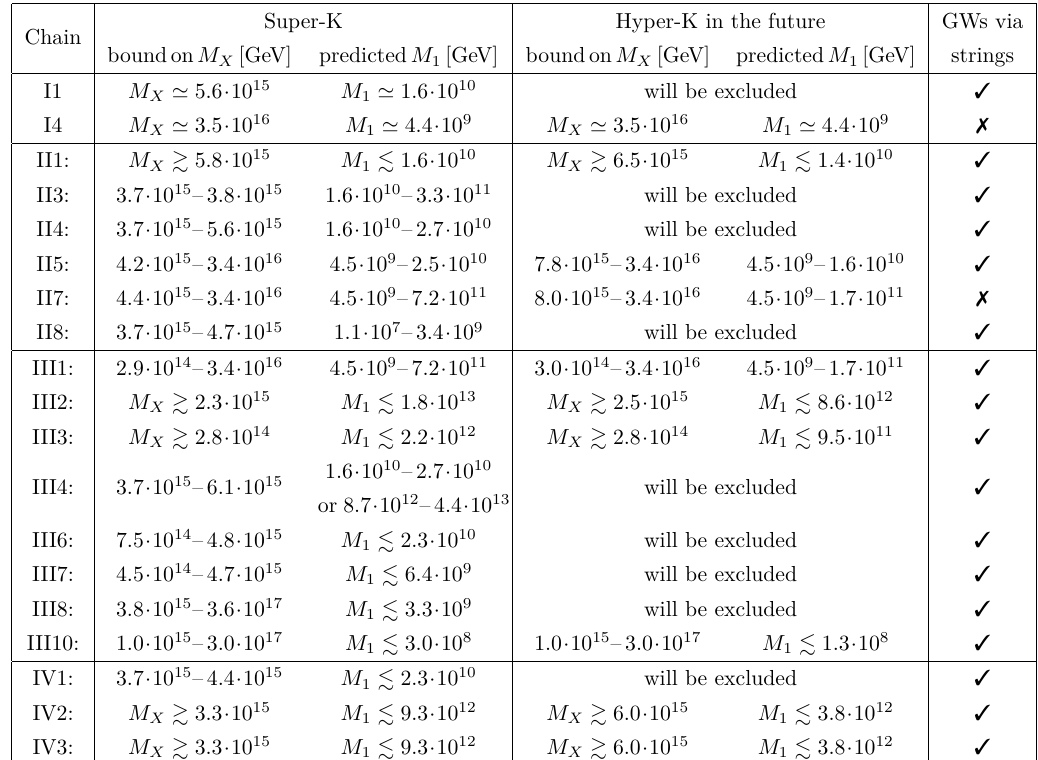
Table 5 . Bounds on the GUT scale, M X , and predicted ranges of the lowest intermediate scale, M 1 , from Super-K and the future Hyper-K experiment if a null result of the proton decay is observed after a 10-year exposure. For each breaking chain, the gauge unification connects the intermediate scales with the GUT scale and gauge couplings. Super-K has set a lower bound on the proton lifetime τ > 1 . 6 × 10 34 years and Hyper-K is expected to set a bound τ > 1 . 4 × 10 35 years π 0 e π 0 e in the future. This information can be transformed to bounds on M and further transformed X to information of the prediction of any intermediate scales, e.g., M , using RG running and the 1 constraint of gauge unification. In this table, only breaking chains that have not been excluded are shown. The last column indicates if the chain generates observable GWs from cosmic strings. In order to generate such observable GWs, cosmic strings, but no other unnecessary topological defects should be generated from the last step of intermediate symmetry